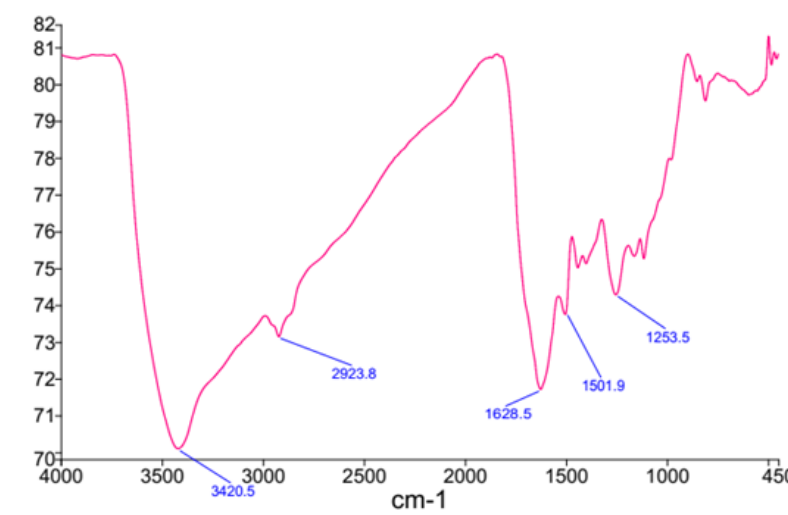
Figure 4. FTIR spectrum of AgNPs synthesized by M. piperita leaf aqueous extract.